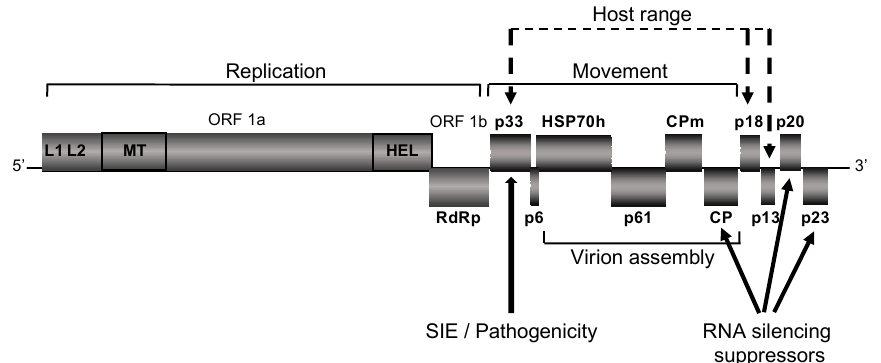
Figure2. SchematicdiagramoftheCTVgenomeorganization. Theopenboxesrepresentopenreadingframes Figure 2. Schematic diagram of the CTV genome organization. The open boxes represent open (ORFs)andtheirtranslationproducts. L1,L2,papain-likeleaderproteasedomains;MT,methyltransferase-like reading frames (ORFs) and their translation products. L1, L2, papain-like leader protease domains; domain; HEL, helicase-like domain; RdRp, an RNA-dependent RNA polymerase; HSP70h, HSP70 homolog; MT, methyltransferase-like domain; HEL, helicase-like domain; RdRp, an RNA-dependent RNA CPm, minor coat protein; CP, major coat protein; SIE, superinfection polymerase; HSP70h, HSP70 homolog; CPm, minor coat protein; CP, major coat protein; SIE, superinfection exclusion.